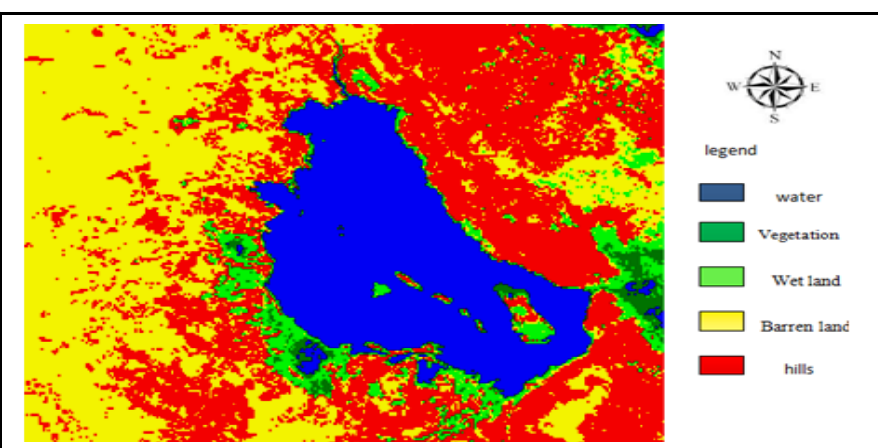
Fig.7: Supervised classification using (SVD) for Landsat-8 (2014).